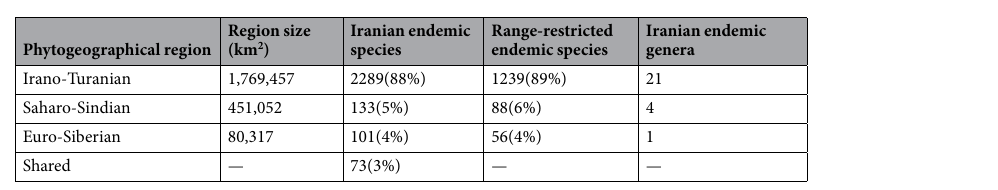
Table 4. Vascular plant endemism in the phytogeographical regions of Iran.